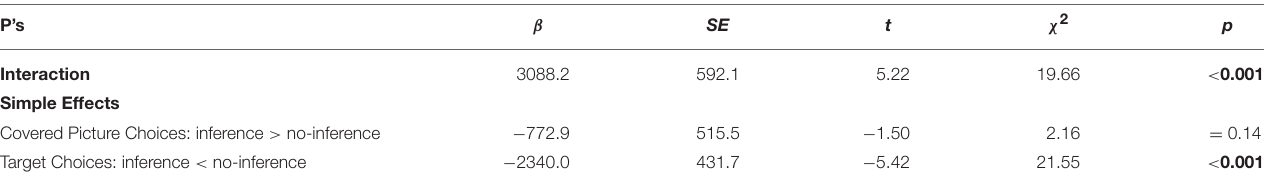
TABLE 3 | Summary of response time analyses for Experiment Ib: Interaction between Picture Choice and inference status and simple effects for relevant paired factor levels. P’s